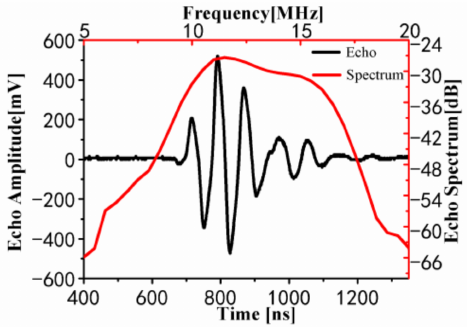
Figure 2. Echo test results of the 12 MHz imaging